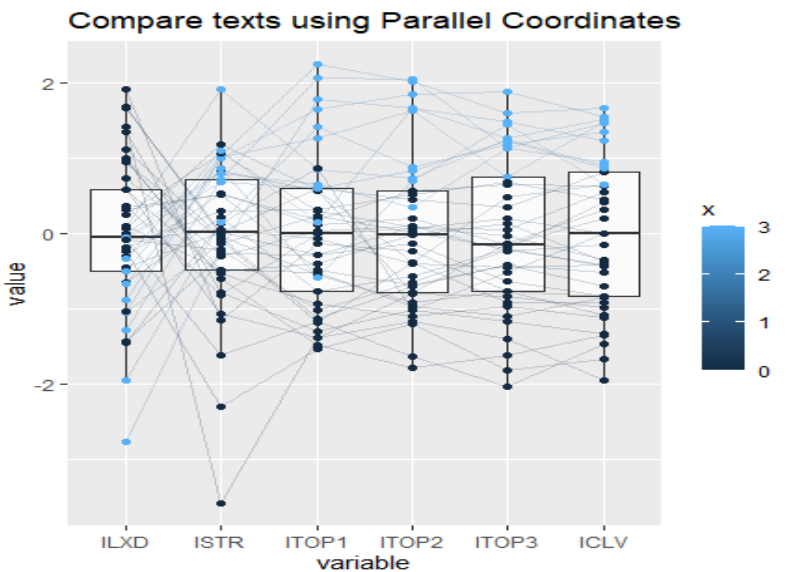
Figure 3. Parallel coordinates graphs for the estimations of latent variables in the model in Figure 2. This plot was obtained with R package MASSGGally: ggparcoord.